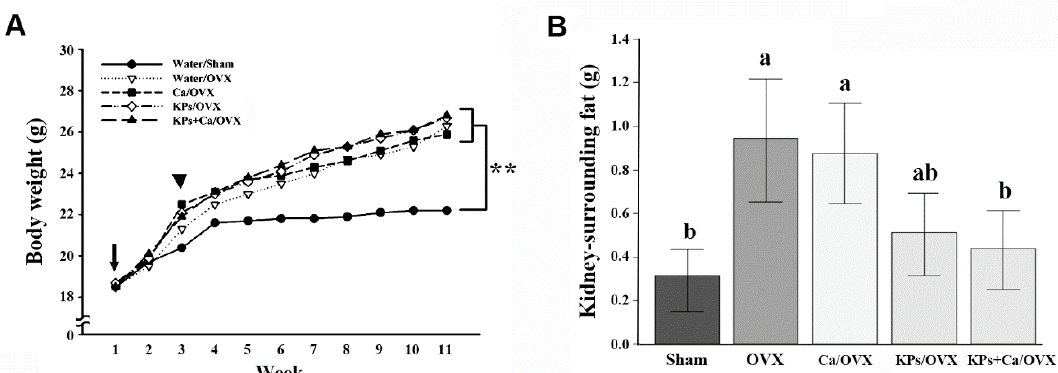
Figure 1. Body weight and kidney-surrounding fat. ( A ) The body weight was measured weekly from the onset of ovariectomy surgery to the end of the experiment. Water/Sham group: blank surgery mice fed with ddH 2 O, Water/OVX group: ovariectomy surgery mice fed with ddH 2 O; Ca/OVX group : ovariectomy surgery mice fed with 10 mg/kg CaCO3; KPs/OVX group: ovariectomy surgery mice fed with 100 mg/kg kefir peptides; KPs+Ca/OVX group: ovariectomy surgery mice fed with 100 mg/kg kefir peptides + 10 mg/kg CaCO3. In this panel, the arrow indicates the onset of surgery and the arrowhead indicates the beginning of oral administration. The mean body weights were higher in all the OVX groups than in the sham group (**, p < 0.01). ( B ) The kidney-surrounding fat was removed and measured immediately at the end of the experiment. The data are presented as means ± SEM ( n = 6). Statistical analysis was performed by one-way ANOVA and Duncan’s post hoc test, and statistical significances are indicated by different letters (a, b; p < 0.05).